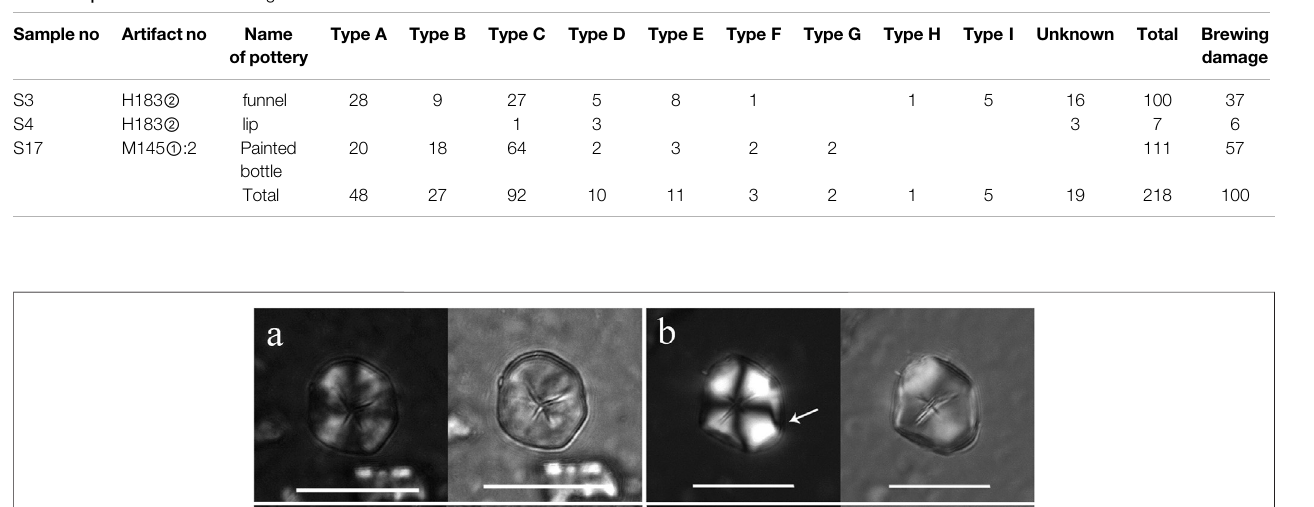
Type D: starch grains ( n = 10, 11.46 – 47.24 μ m) are the circle ( Figure 5D ) and long oval ( Figure 5E ), which have a large size distribution range. Short “ - ” shaped or “ X ” shaped fi ssures can be observed at the hilum, and the extinction arms under polarizing light are cross. The lamellae of this kind of starch grains gradually spread outward around the hilum is obvious, and the hilum of the long oval